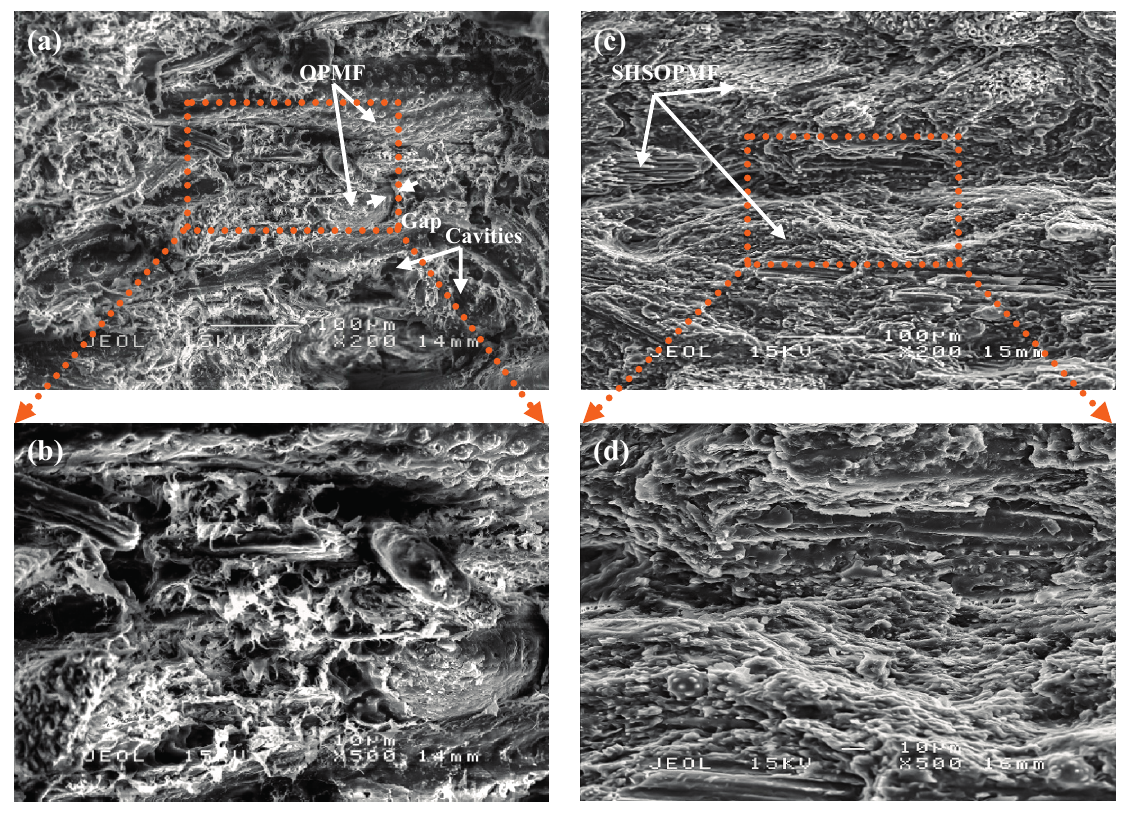
Figure 3. SEM micrographs of untreated OPMF/PBS ( a ), ( b ) and SHSOPMF/PBS ( c ), ( d )